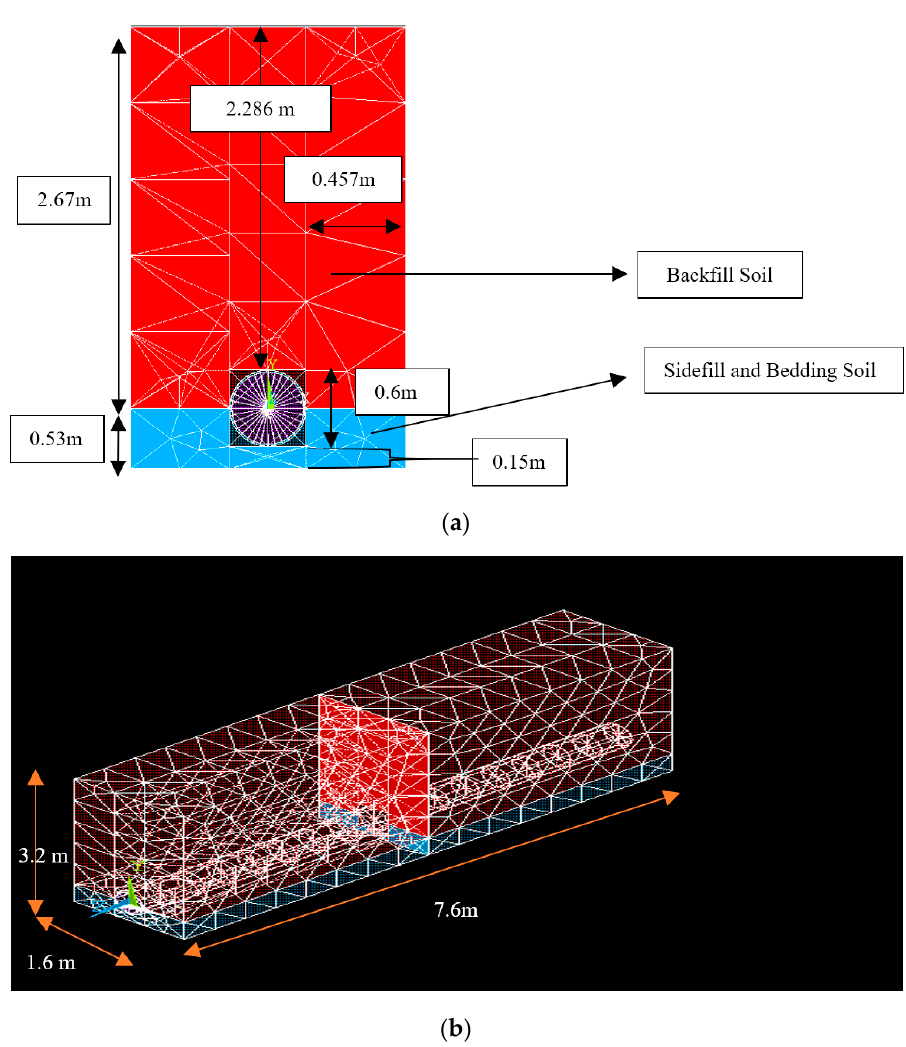
Figure 5. ( a ) 2D and ( b ) 3D pipe models in ANSYS 18.2 (current study).